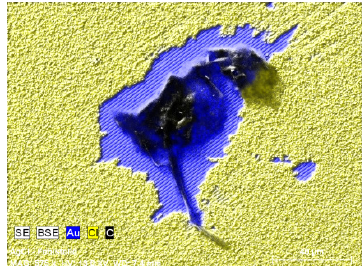
Fig.12: Surface defect at a Ag/AgCl covered gold electrode. The electrode was made from a CD-R carrying a 24-karat gold layer.